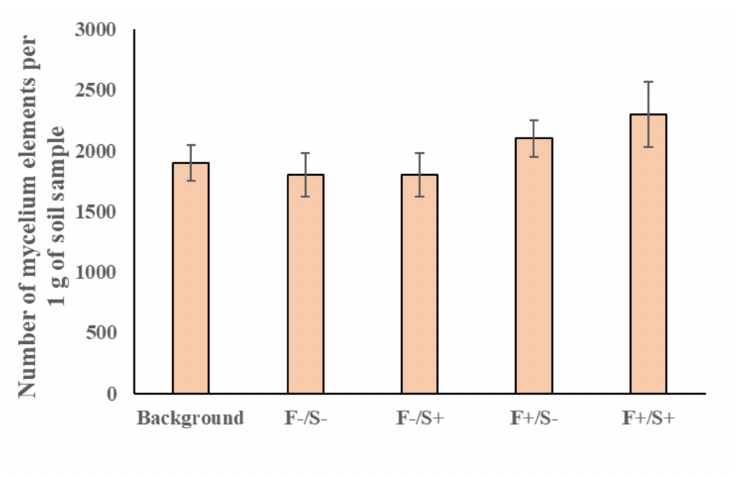
Figure 6. Quantitative characteristic of the microscopic fungi